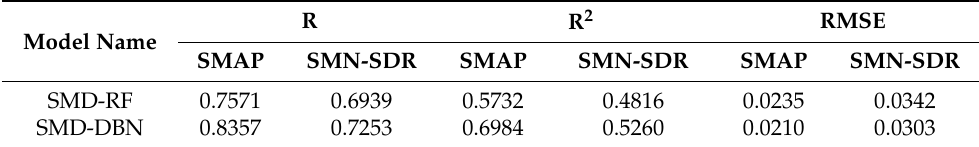
Figure 9. Downscaled SM from SMD-RF (note: white part is a result of using the water mask). The data and method used to verify the SMD-RF model are the same as those of the SMD-DBN model. A performance comparison between SMD-DBN and SMD-RF is shown in Table 7 and Figure 10. Table 7. Accuracy evaluation of the two models.